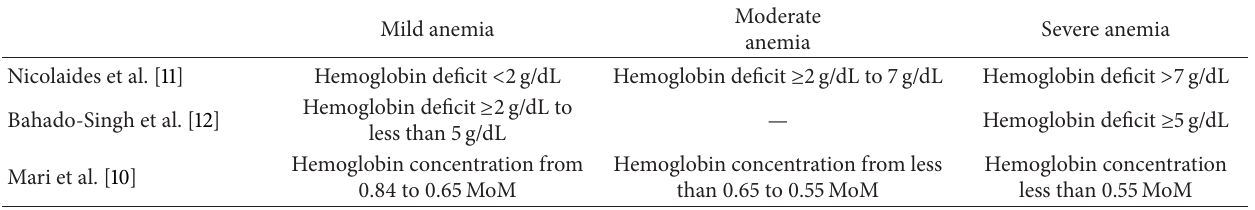
Table 3: Criteria for diagnosis and classification of fetal